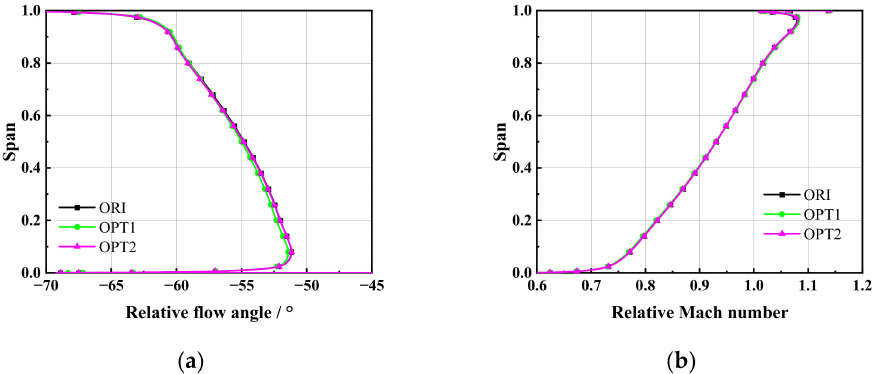
Figure 11. Spanwise distributions of the rotor inlet flow angle and Mach number: ( a ) relative flow angle; ( b ) relative Mach